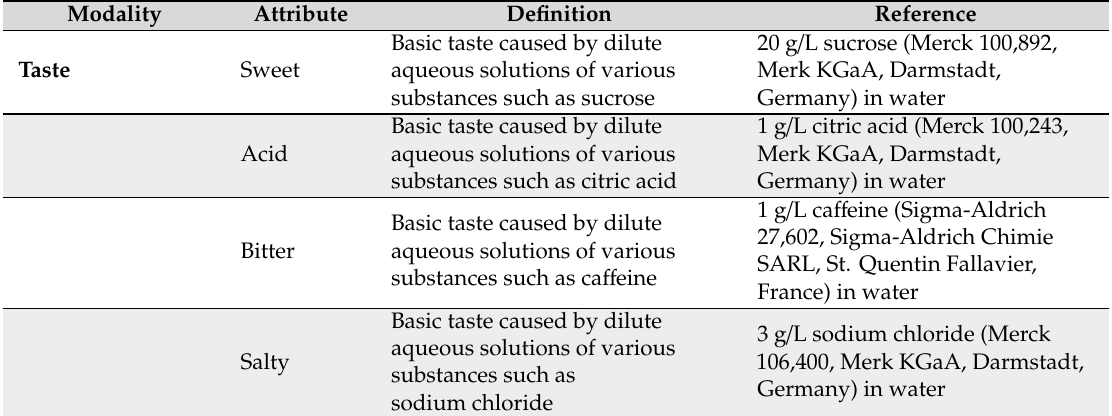
Table 2. List of attributes, definition and references used for temporal dominance of sensations (TDS) and temporal check-all-that-apply